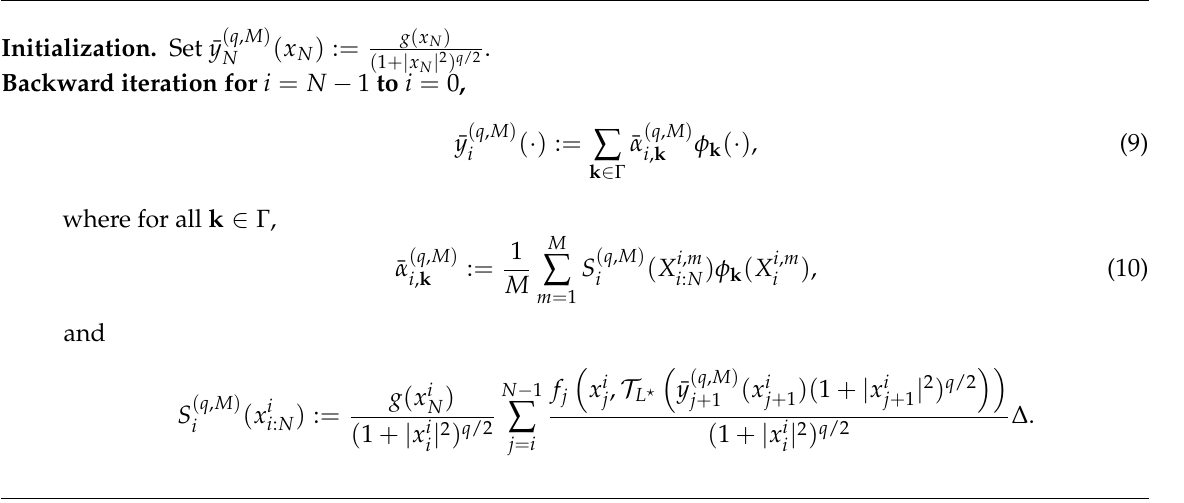
Algorithm 1. Global Quasi-Regression Multistep-forward Dynamical Programming (GQRMDP)